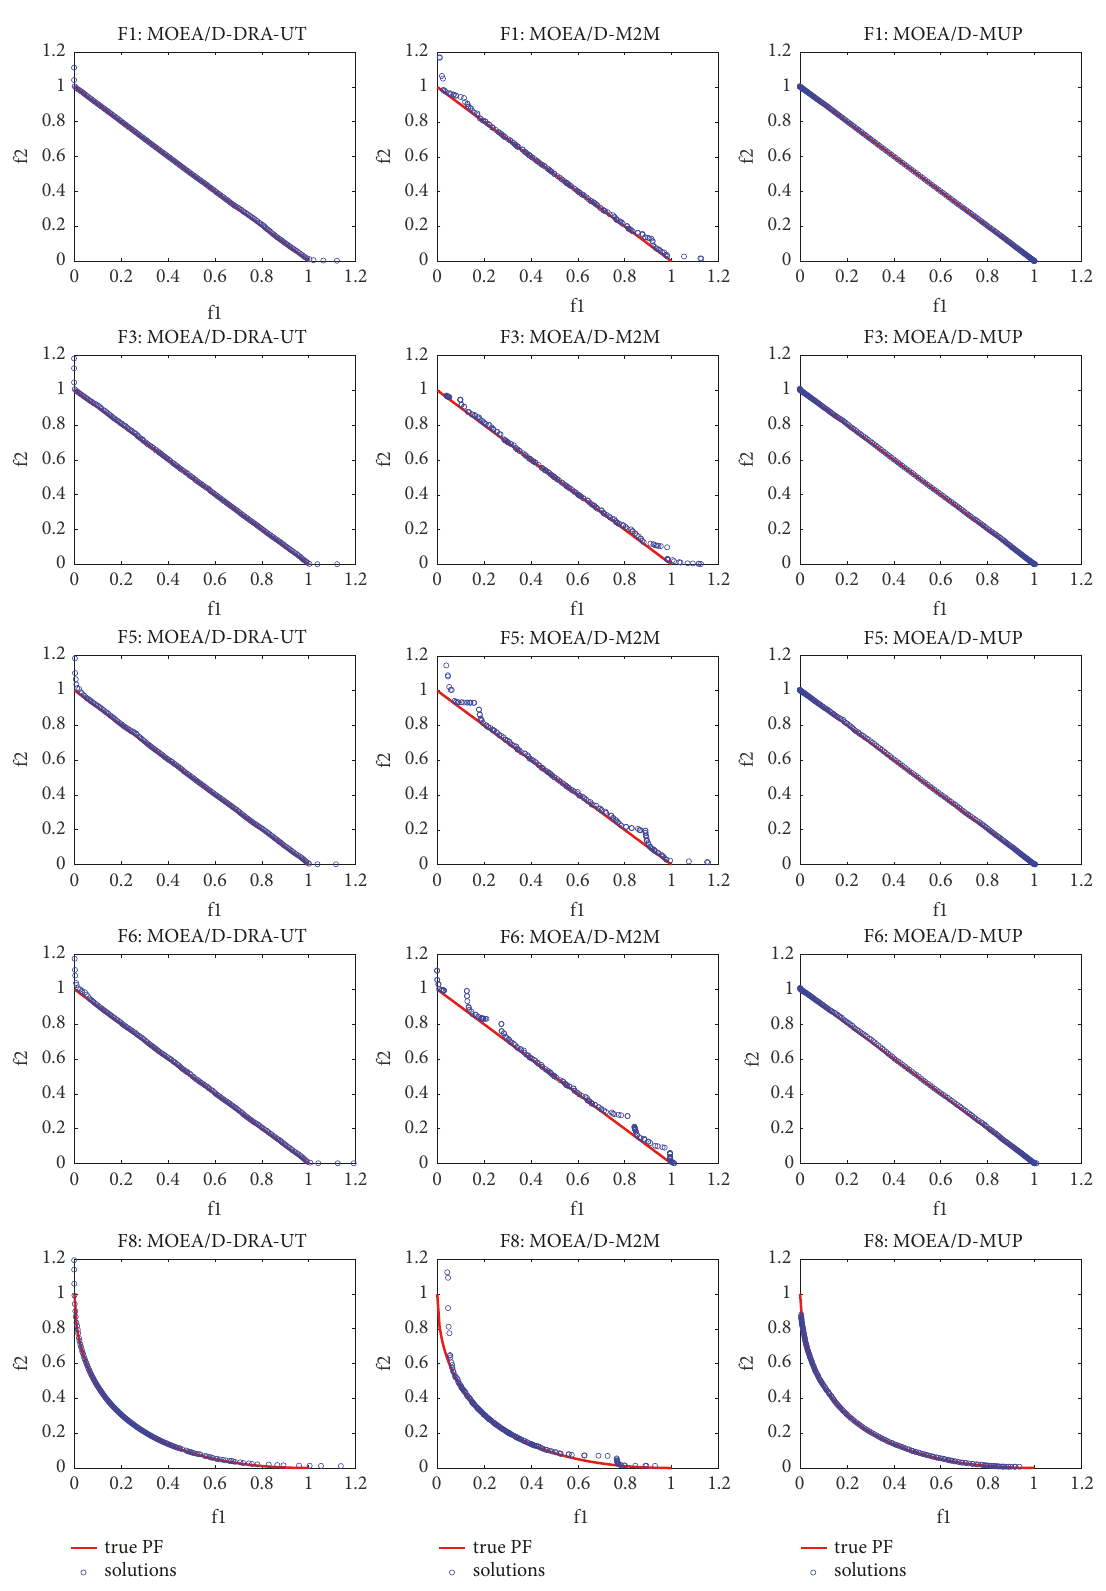
Figure 8: The final populations obtained by MOEA/D-DRA-UT, MOEA/D-M2M, and MOEA/D-MUP on F3, F5, F6, and